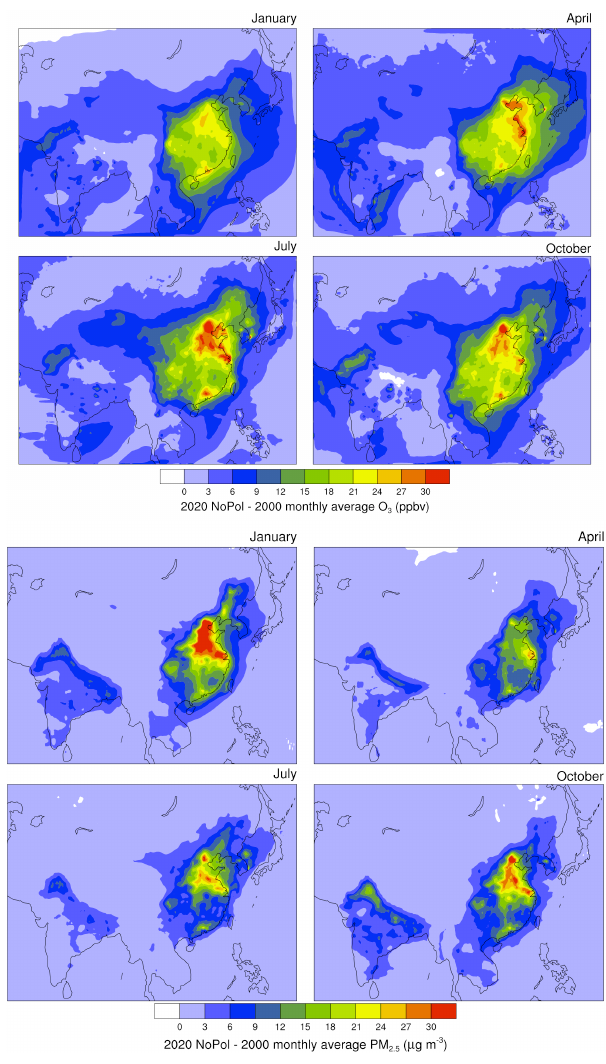
Fig. 9. Comparison of 2020 NoPol and 2000 baseline (2020NoPol– 2000 baseline) surface O 3 mixing ratios [ppbv] (top), and PM 2.5 concentrations [ µ g m -3 ] (bottom) in January, April, July and October modelled by WRF/Chem.